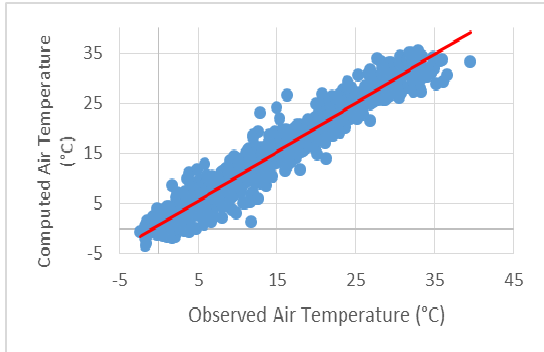
Figure 6. Scatterplots of computed air temperature against